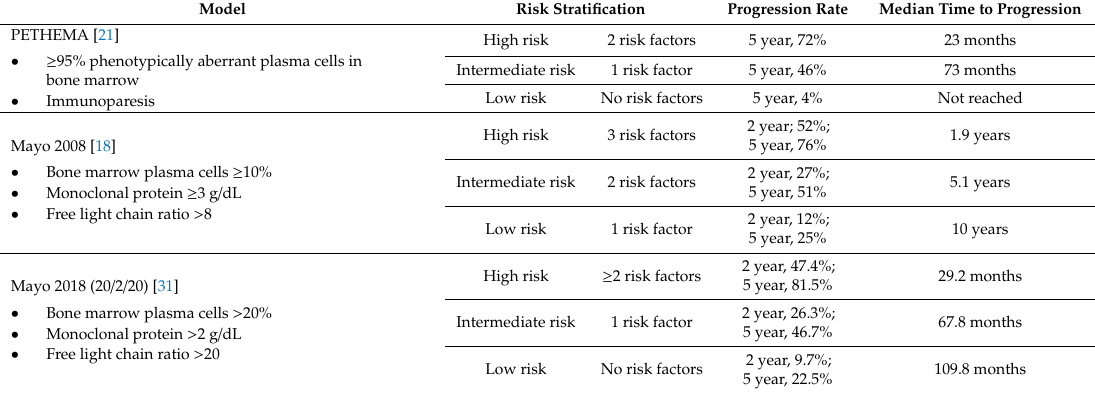
Table 2. Summary of commonly the used smoldering multiple myeloma (SMM) risk stratification